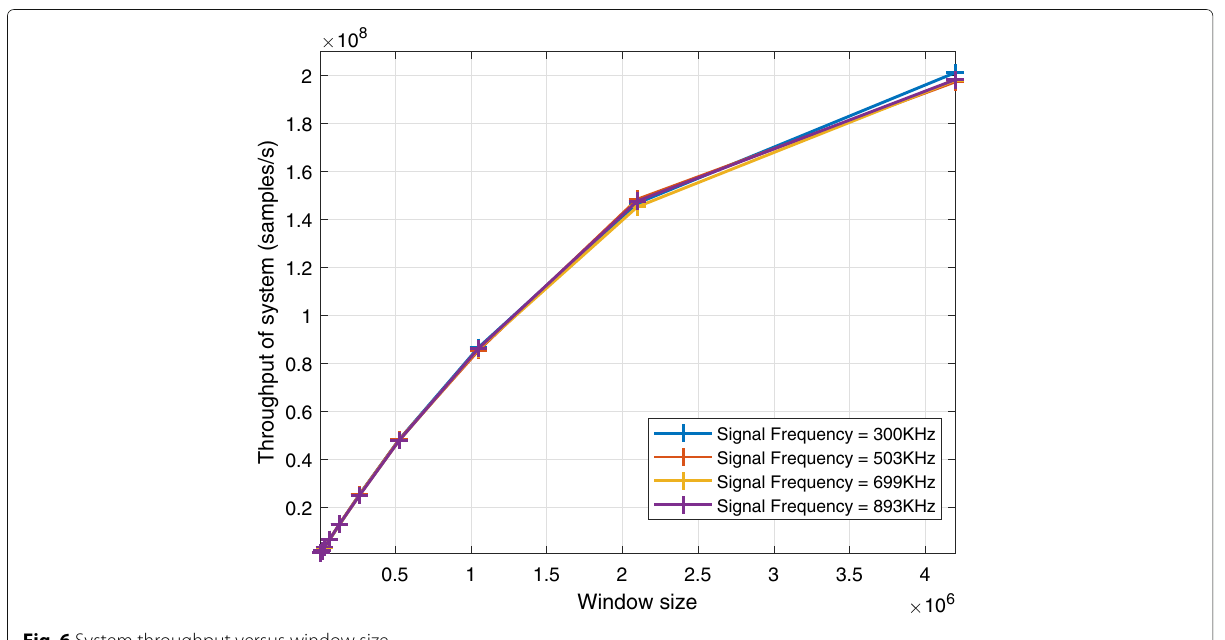
Fig. 6 System throughput versus window size